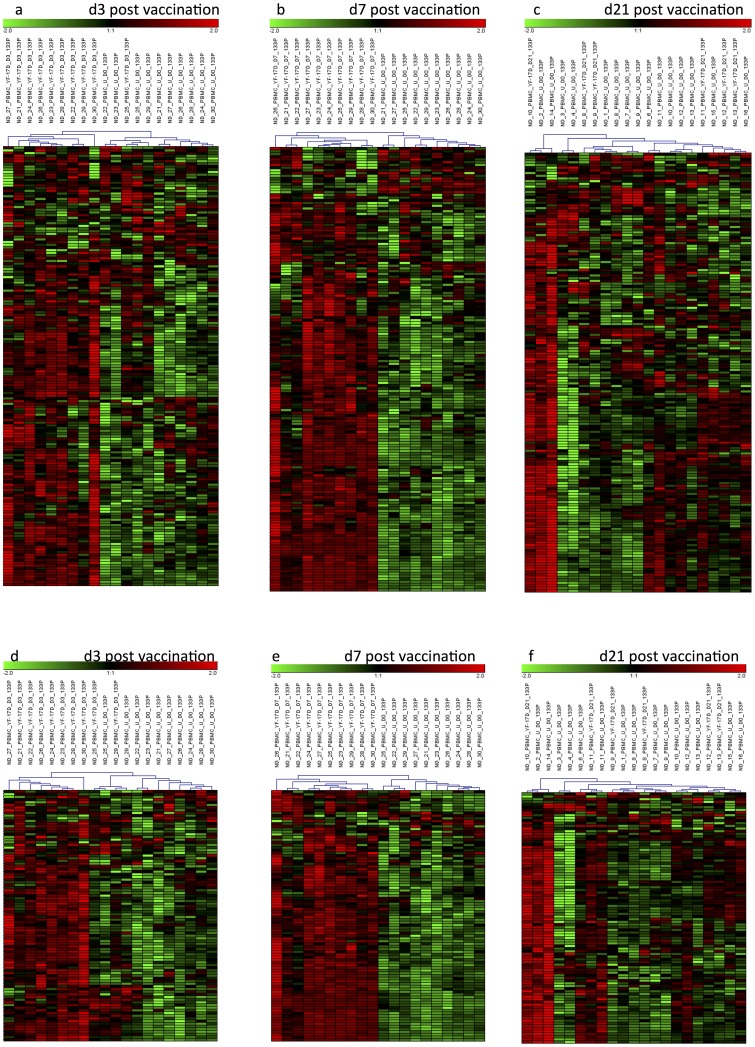
For the validation of 165 monocyte- (a, b and c) and 94 T helper lymphocyte-specific (d, e and f) common-IFN signature genes, their expression were followed in PBMC's of an independent cohort of yellow-fever vaccinated individuals.Expression profiles were generated from PBMC's at day 3 (a and d), 7 (b and e) and 21 (c and f) after vaccination and compared to baseline levels at d0. Both, the common type I interferon signatures of monocytes and CD4 lymphocytes allowed the monitoring of the induction of interferon responses in PBMCs at d3, peaking at d7 and almost declining at d21.